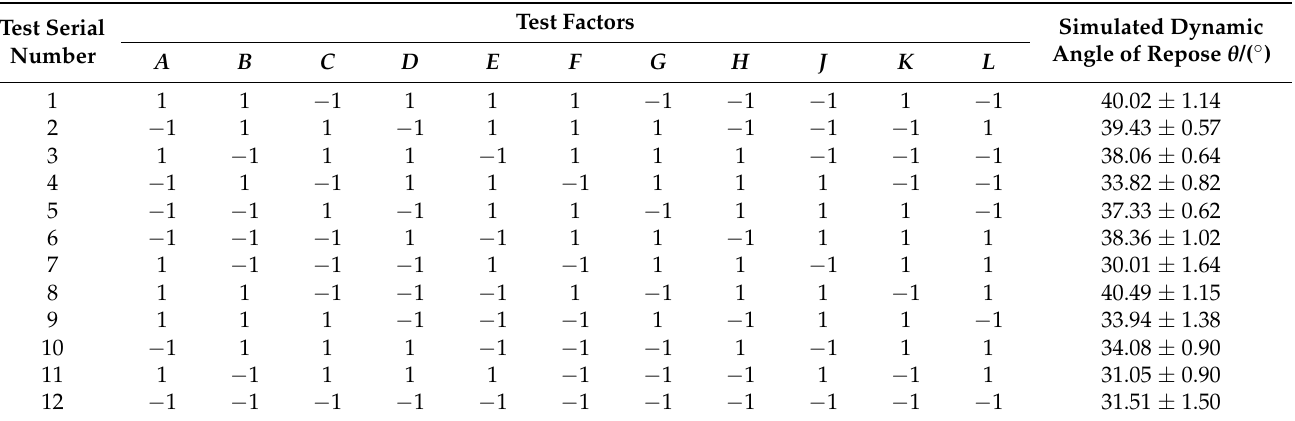
Table 3. Plackett–Burman test protocol and